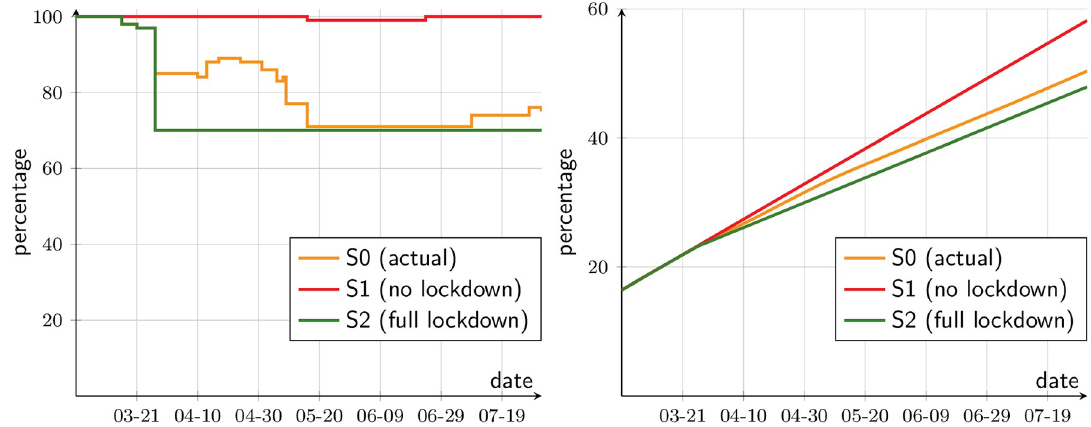
Fig 10. Output in counterfactual scenarios. (a) As a percentage of the baseline, daily, production. (b) As a percentage of the baseline, yearly, production.